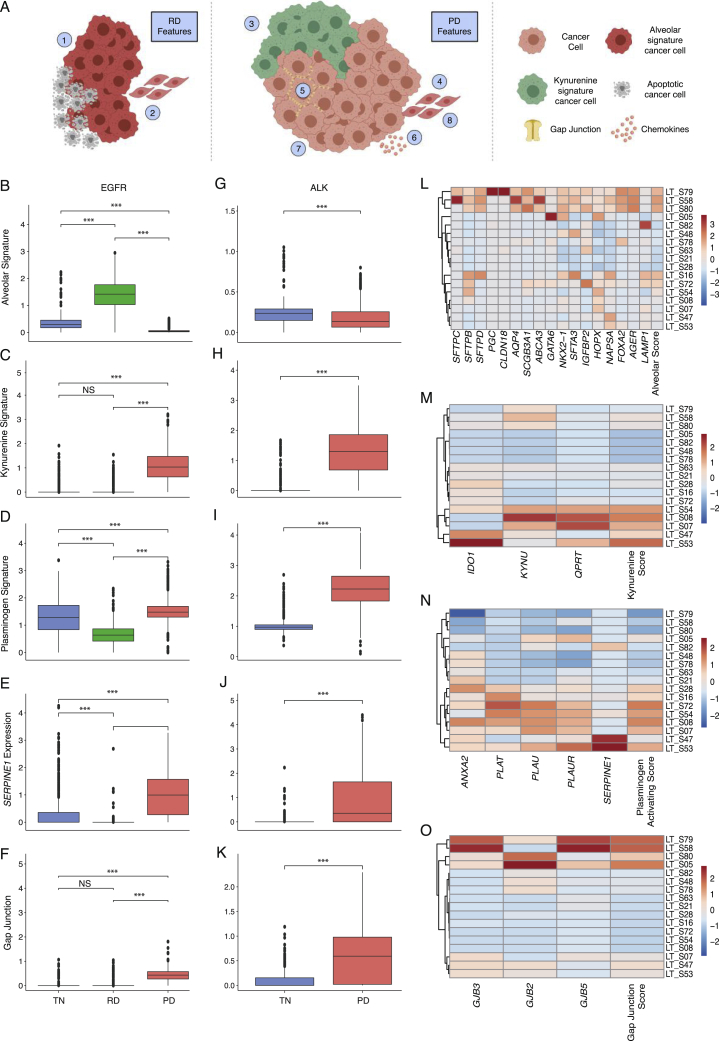
Related to Figure 3(A) Graphical summary of cancer cell expression changes across treatment time points. RD features include (1) Alveolar signature, and (2) various RD specific invasive signaling pathways. PD features include: (3) kynurenine signature, (4) plasminogen activation and SERPINE1 signatures, (5) gap junction proteins, (6) expression of pro-inflammatory chemokines, (7) loss of tumor suppressor genes, and (8) various PD specific invasive signaling pathways. (B-F) Boxplots of pathway signature changes (alveolar, kynurenine, plasminogen activating, SERPINE1, and gap junction, respectively) across treatment time points within only EGFR mutant cancer cells (∗∗∗ indicates a p value < 0.0001). (G-K) Boxplots of pathway signature changes (alveolar, kynurenine, plasminogen activating, SERPINE1, and gap junction, respectively) across treatment time points within only ALK cancer cells (∗∗∗ indicates a p value < 0.0001). (L-O) Heatmap of sample average expression with PD only cancer cells for each cancer derived signature gene (alveolar, kynurenine, plasminogen activating/SERPINE1, and gap junction, respectively).